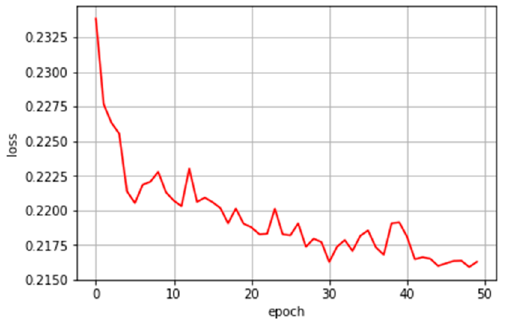
Figure 5. Train loss during training with early stopping.